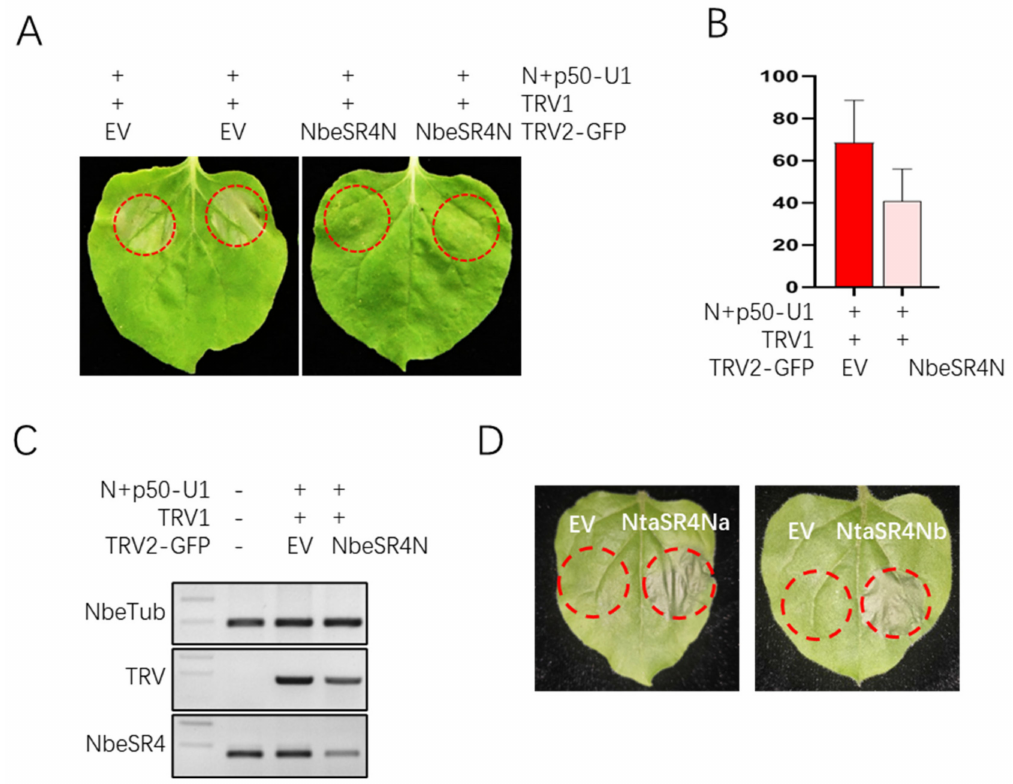
Figure 3. SR4N positively regulates cell death. ( A ) Cell death phenotype triggered by co-infiltration of N and p50 on N. benthamiana plants treated by control (left) and SR4N (right) VIGS vectors. Red circles mark the patches co-infiltrated with N and p50 Agrobacteria. ( B ) Statistical analysis of the cell death rate in the plants treated by control (left) and SR4N (right) VIGS vectors. Patches with HR/total infected patches indicate the cell death rate. A two-tailed Student’s t-test was used for comparison between the two samples using GraphPad Prism 8. ( C ) RT-PCR analysis of SR4N expression levels in VIGS experiments. Target genes are indicated to the left, and samples are indicated at the bottom of each lane. WT: wild-type untreated sample. ( D ) Cell death phenotype on SR4N overexpressed leaves. Infiltrated patches are marked by red circles, and vectors used for infiltration are indicated above each